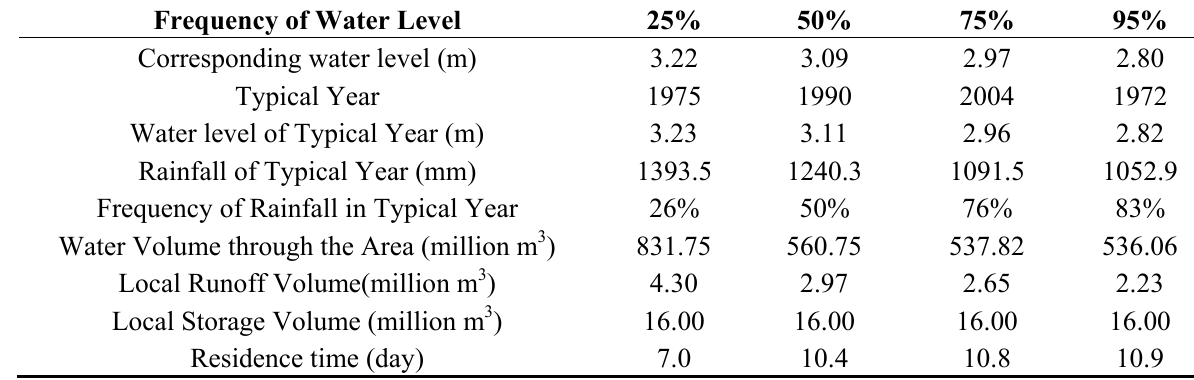
Table 3. Residence times for the typical years ensured by water level